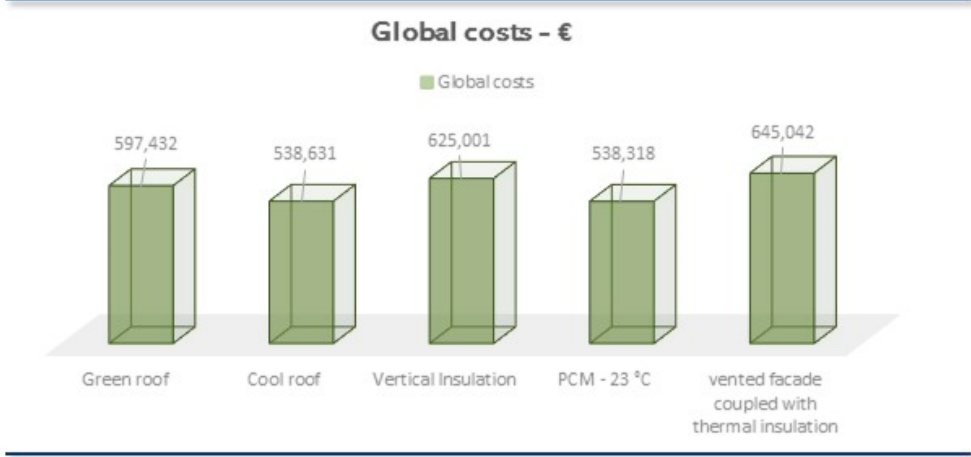
Figure 18. GC global costs of the considered energy efficiency measures—calculation period of 30 years.